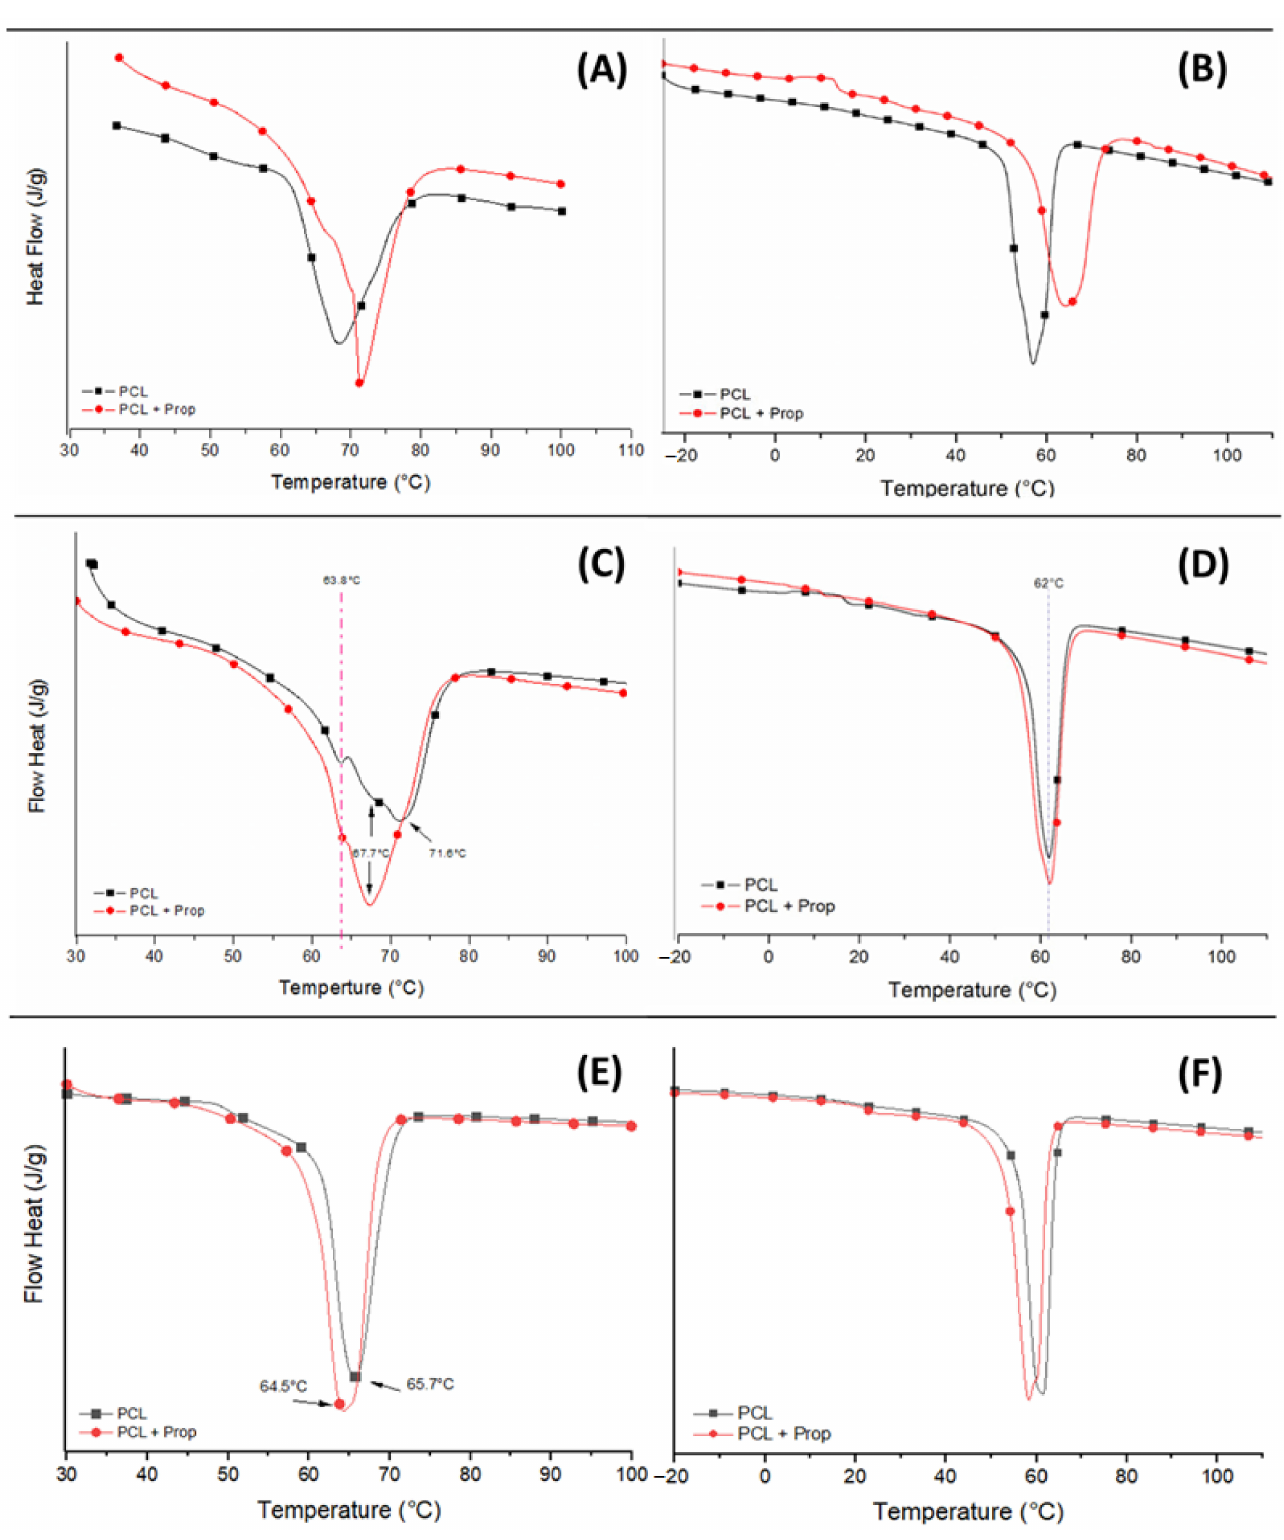
Figure 4. DSC curves of electrospun PCL and PCL + Prop mats: first and second heating, respectively. ( A , B ) Fibres, ( C , D ) beaded fibres, and ( E , F )